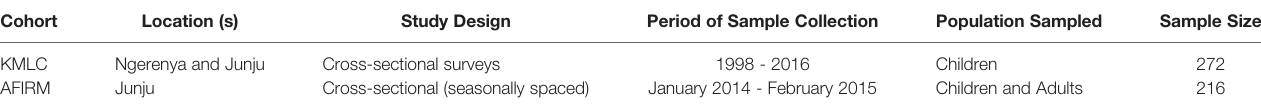
TABLE 1 | Summary of the cohorts included in the immunopro fi